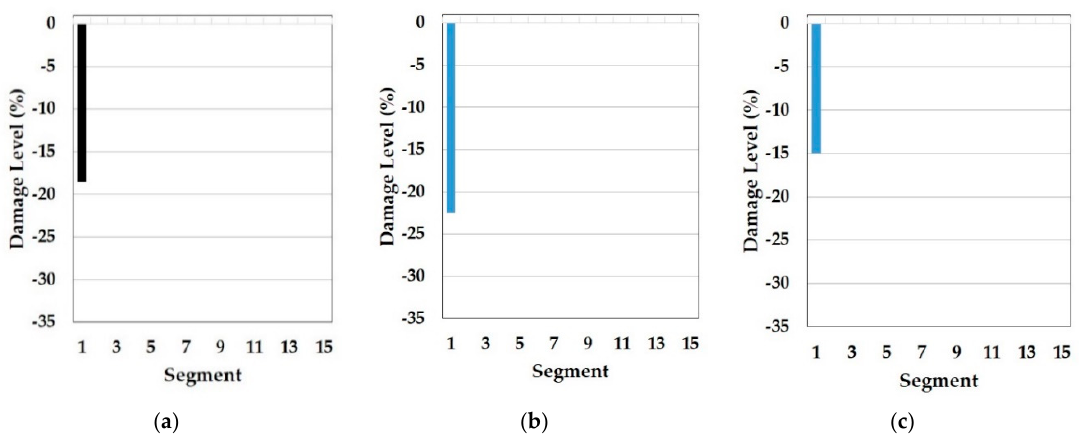
Sensors 2019 , 19 , x FOR PEER REVIEW Figure 11. Symmetric baseline model under DS1 (blue color is correct segment whereas orange color is incorrect segment): ( a ) Predicted damage from the GA (black color); ( b ) top one damage case using the first to third natural frequencies; ( c ) top two damage case using the first to third natural frequencies.